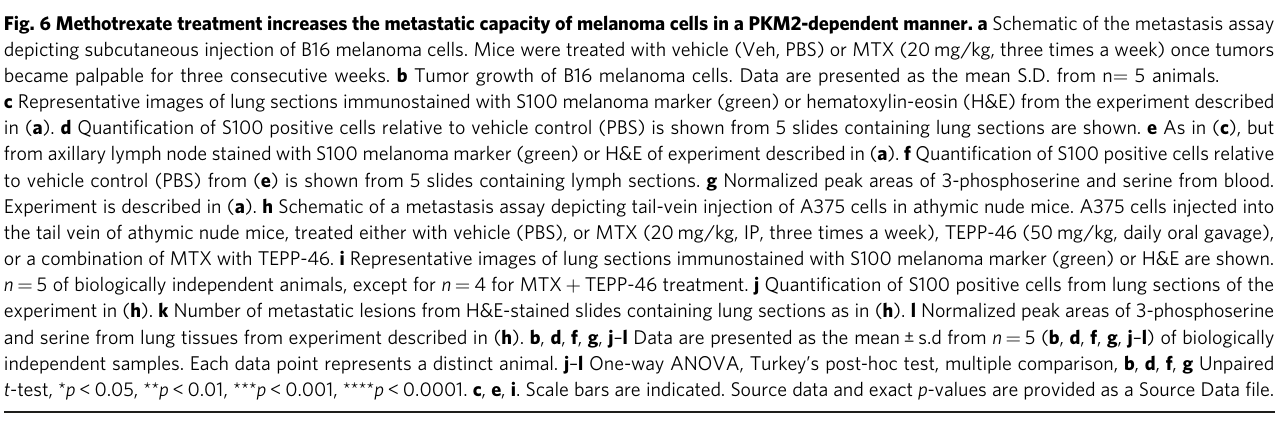
Fig. 6 Methotrexate treatment increases the metastatic capacity of melanoma cells in a PKM2-dependent manner. a Schematic of the metastasis assay depicting subcutaneous injection of B16 melanoma cells. Mice were treated with vehicle (Veh, PBS) or MTX (20 mg/kg, three times a week) once tumors became palpable for three consecutive weeks. b Tumor growth of B16 melanoma cells. Data are presented as the mean S.D. from n = 5 animals. c Representative images of lung sections immunostained with S100 melanoma marker (green) or hematoxylin-eosin (H&E) from the experiment described from axillary lymph node stained with S100 melanoma marker (green) or H&E of experiment described in ( a ). f Quanti fi cation of S100 positive cells